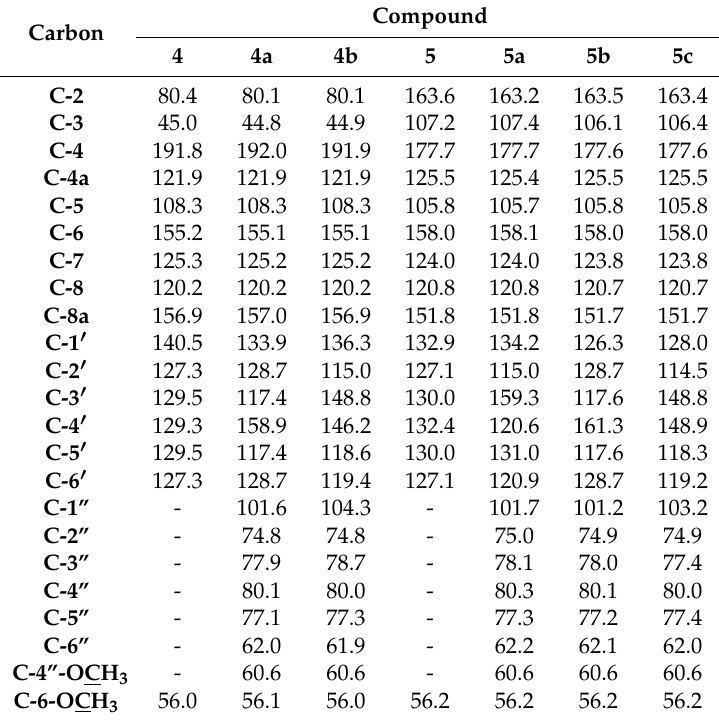
Table 6. The 13 C-NMR shifts ( δ ) (ppm) of 6-methoxyflavanone ( 4 ) and 6-methoxyflavone ( 5 ) and the products of their biotransformations ( 4a , 4b , 5a , 5b , 5c ) in Acetone-d 6 , 151 MHz (Supplementary